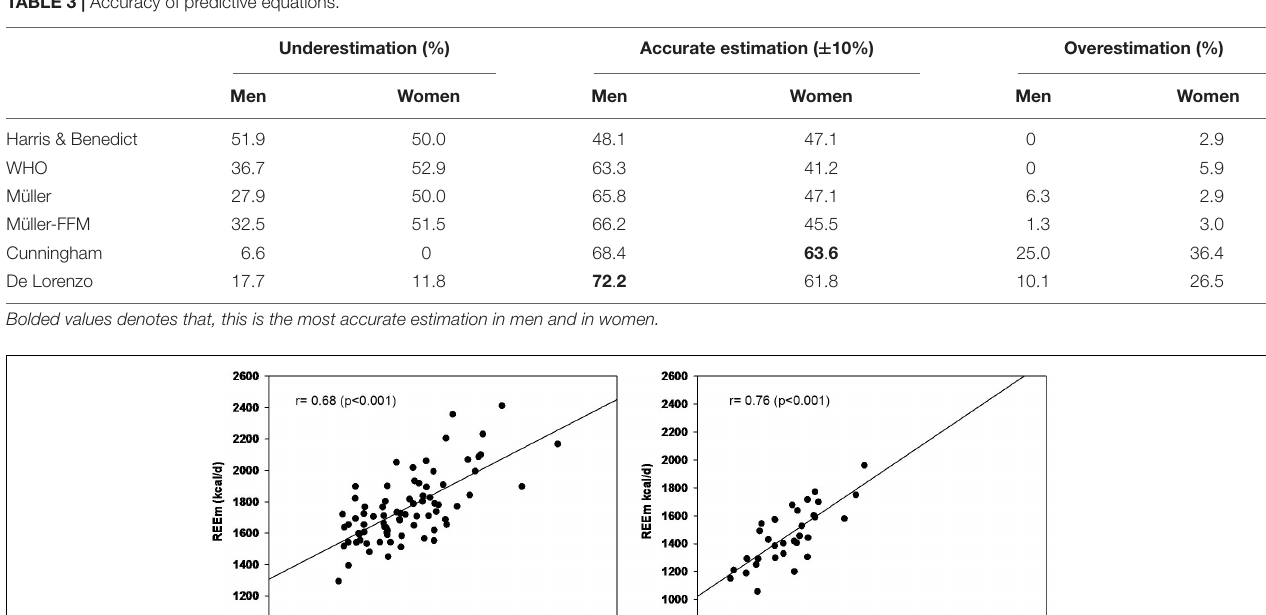
TABLE 3 | Accuracy of predictive equations.